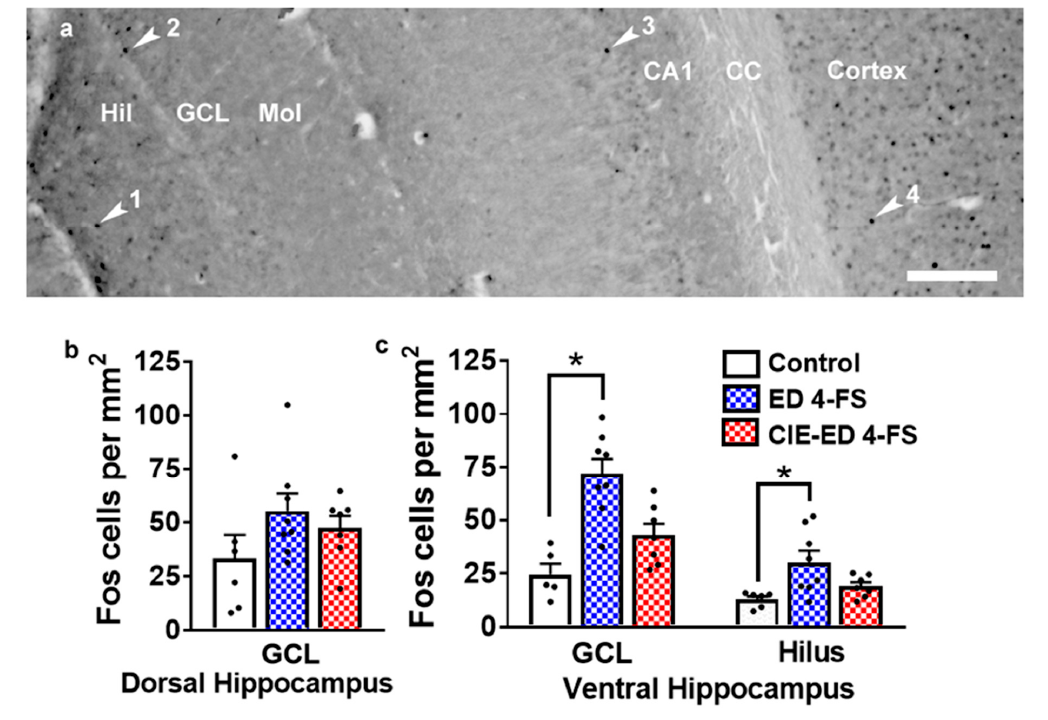
Figure 7. Fos expression is altered by 4-FS. ( a ) Photomicrograph of Fos immunohistochemistry in the hippocampus and cortex from one control rat. Fos + cells appeared as single cells; each immunoreactive cell is pointed with an arrowhead. 1 ‐ Fos+ cell in the hilus (Hil); 2 ‐ Fos+ cell in the granule cell layer (GCL); 3 ‐ Fos+ cell in the CA1 region; 4 ‐ Fos+ cell in the cortex. Mol, molecular layer. Scale bar is 100 µ m. ( b , c ) Number of Fos+ cells in the dorsal ( b ) and ventral ( c ) hippocampus. n = 8 4-FS ED rats, n = 7 4-FS CIE ‐ ED rats. * p < 0.05, compared to controls. Data are expressed as mean ± S.E.M.